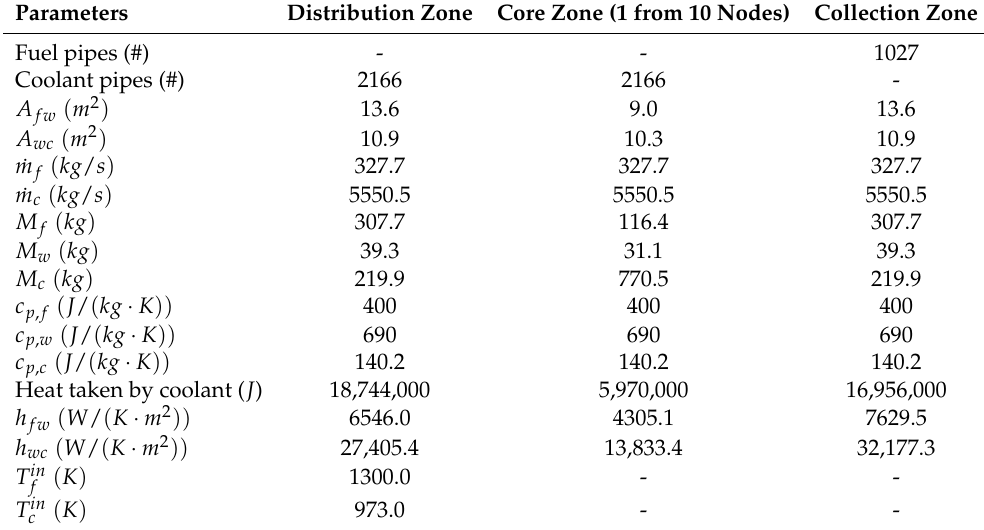
Table 3. Thermodynamics